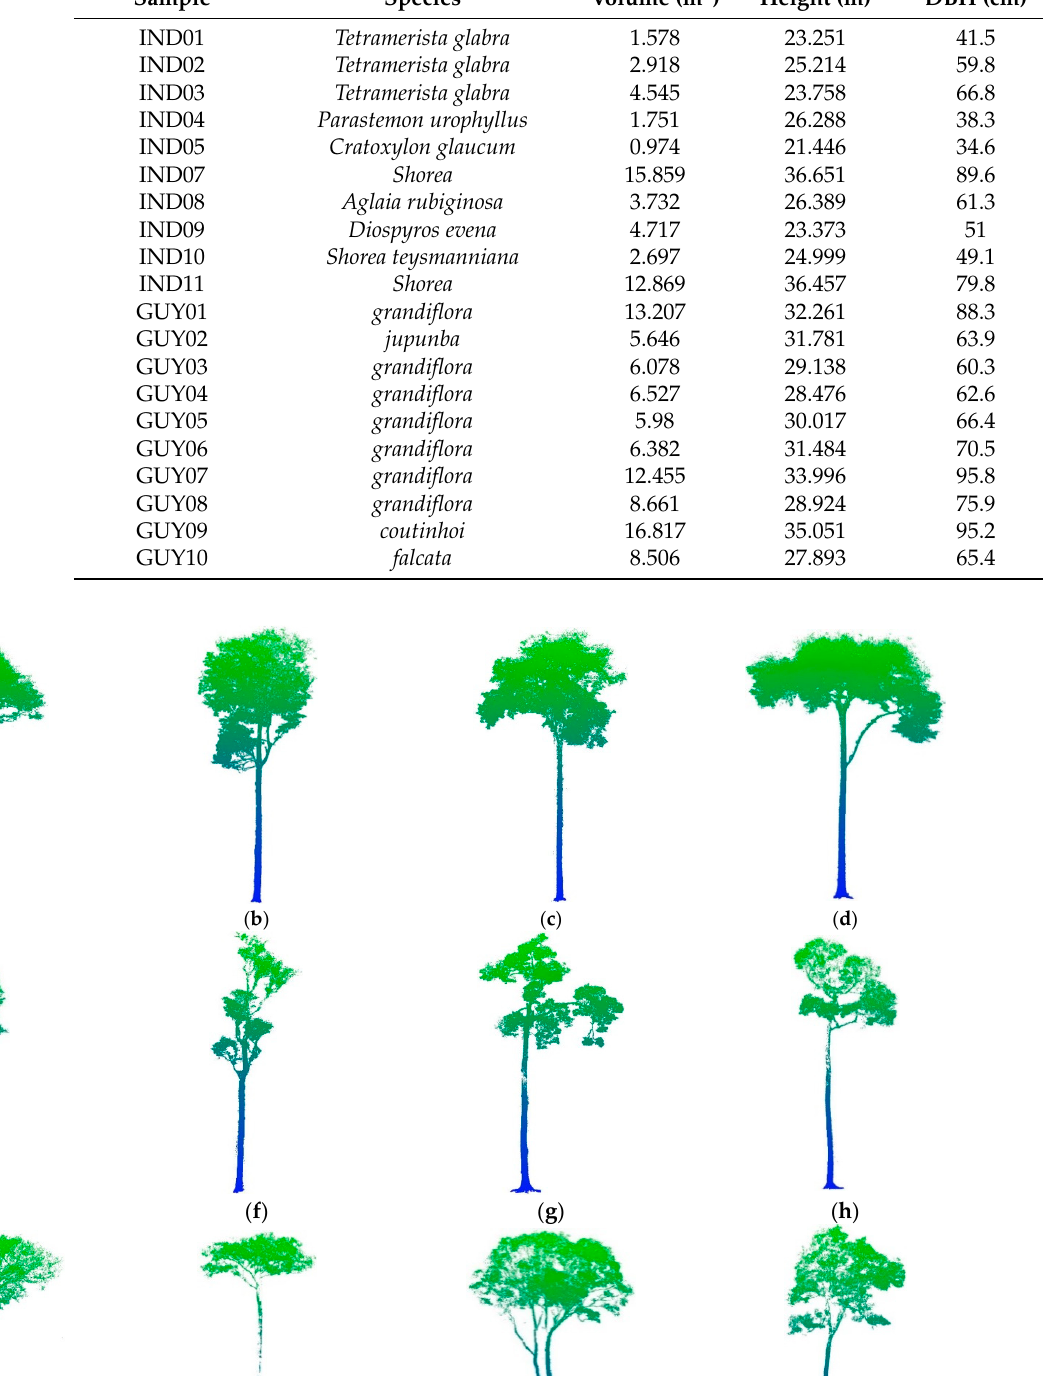
Table 1. Characteristics of the 29 datasets.